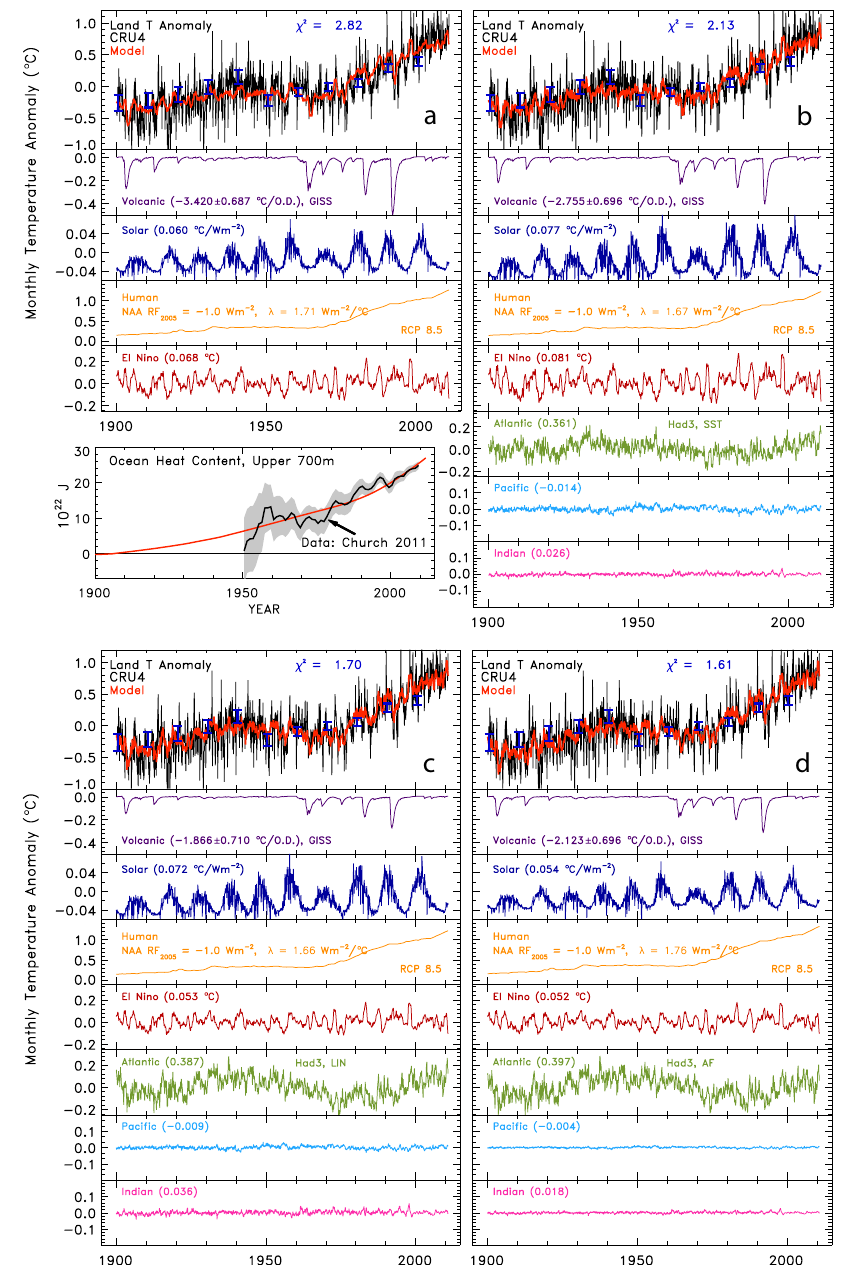
Fig. 9. Same as Fig. 6, but for MLR simulation of the land temperature anomaly from CRU4.